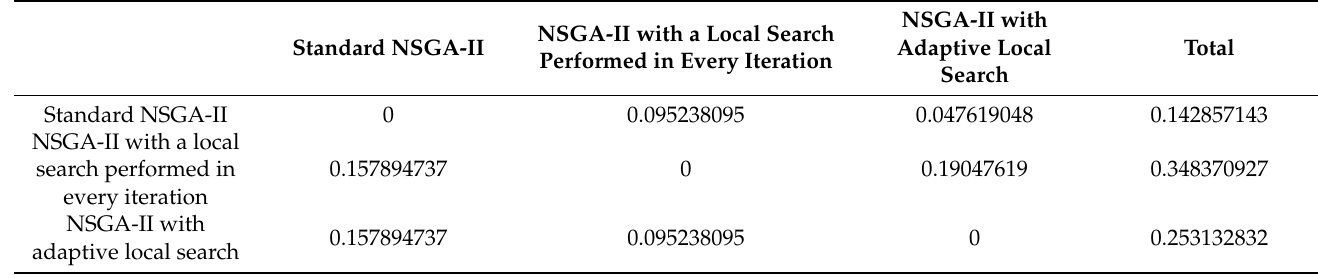
Table 11. Convergence metric.